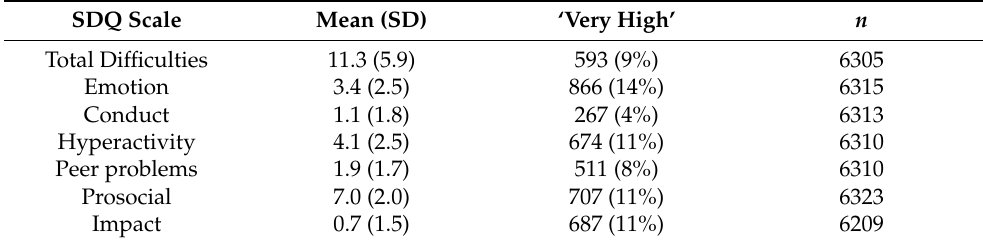
Table 3. Pupil completed SDQ results.